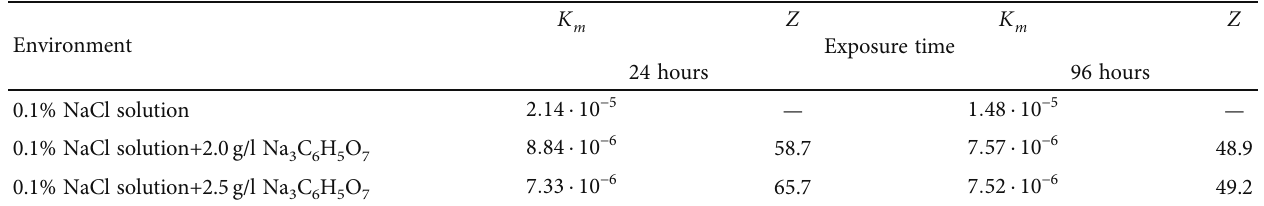
, g/cm 2 ∙ h) and degree of protection ( Z , %) of 09G2S steel in 0.1% NaCl solution. m